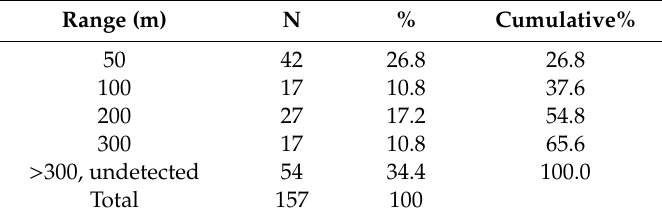
Table 6. Summary of the range distance (m) between observed sites and the closest kelp grid cell. Range (m) N